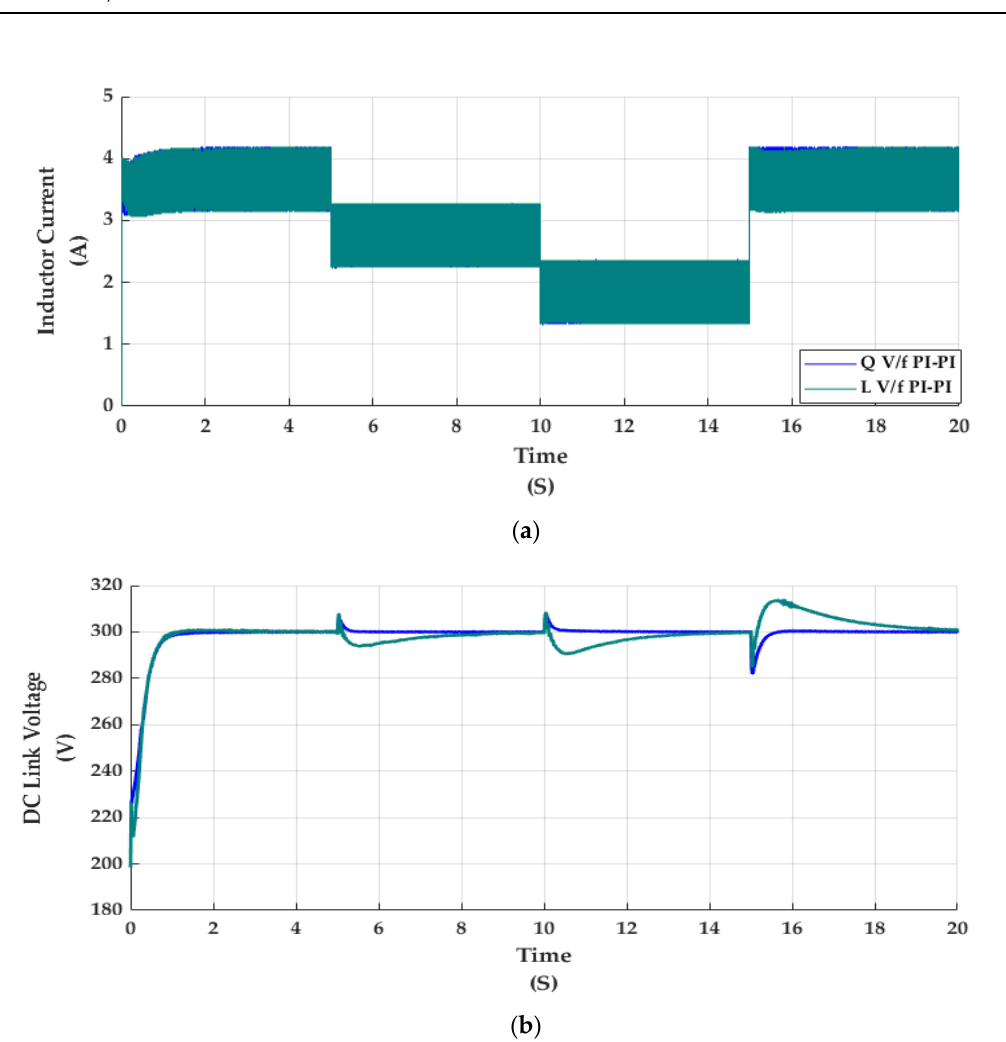
Figure 7. Simulation results of the proposed Q V/f compared to the conventional L V/f: ( a ) Inductor current; ( b ) DC link voltage; ( c ) Motor speed; ( d ) Motor torque; ( e ) RMS phase